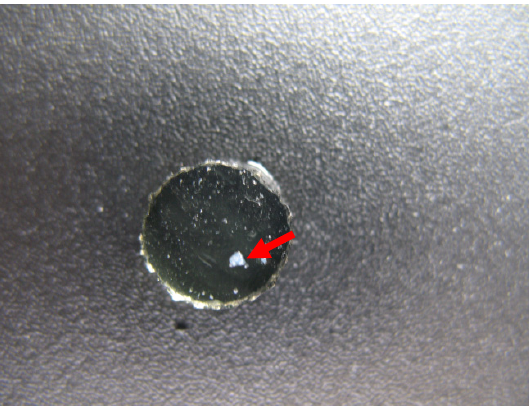
Figure 3. Ciprofloxacin precipitate on the surfaces of DMAA TRIS + HA 35 kDa